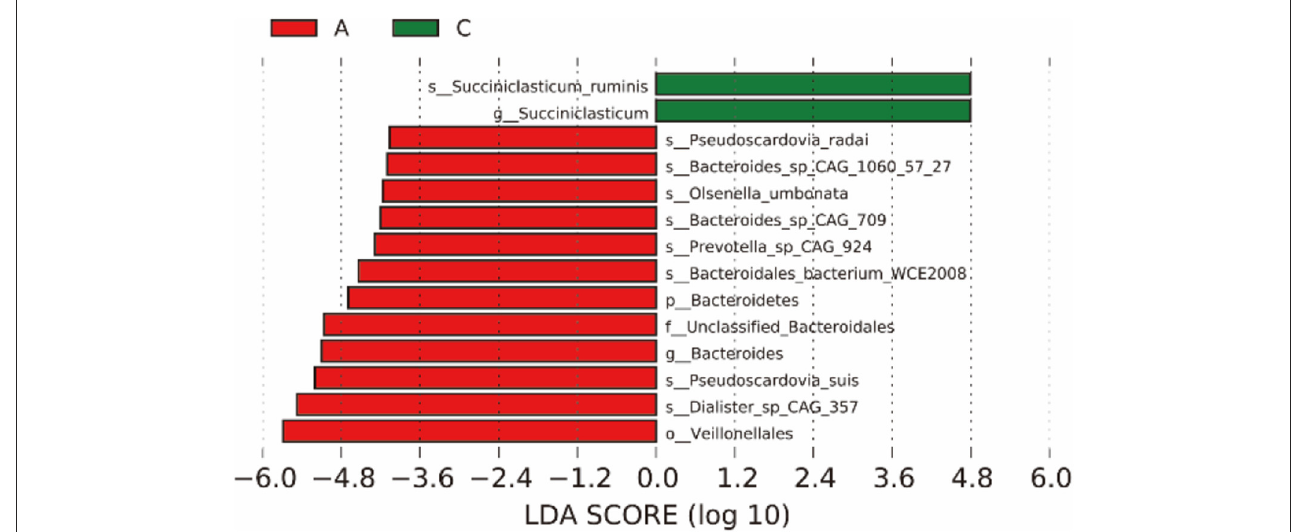
FIGURE3 The left figure shows the LDA value distribution of different species. The histogram of LDA value distribution shows the species whose LDA score is greater than the set value (the default value is 4), that is, the Biomarker with statistical difference between groups. The length of the bar graph represents the impact of different species (LDA